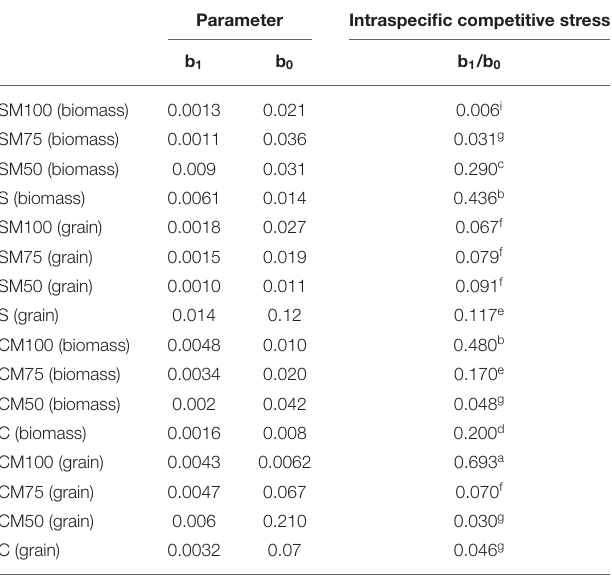
TABLE 2 | The initial chemical properties of the soil at the Muzokomba area, experimental field, and cattle manure used in the study. Parameter Soil Cattle manure